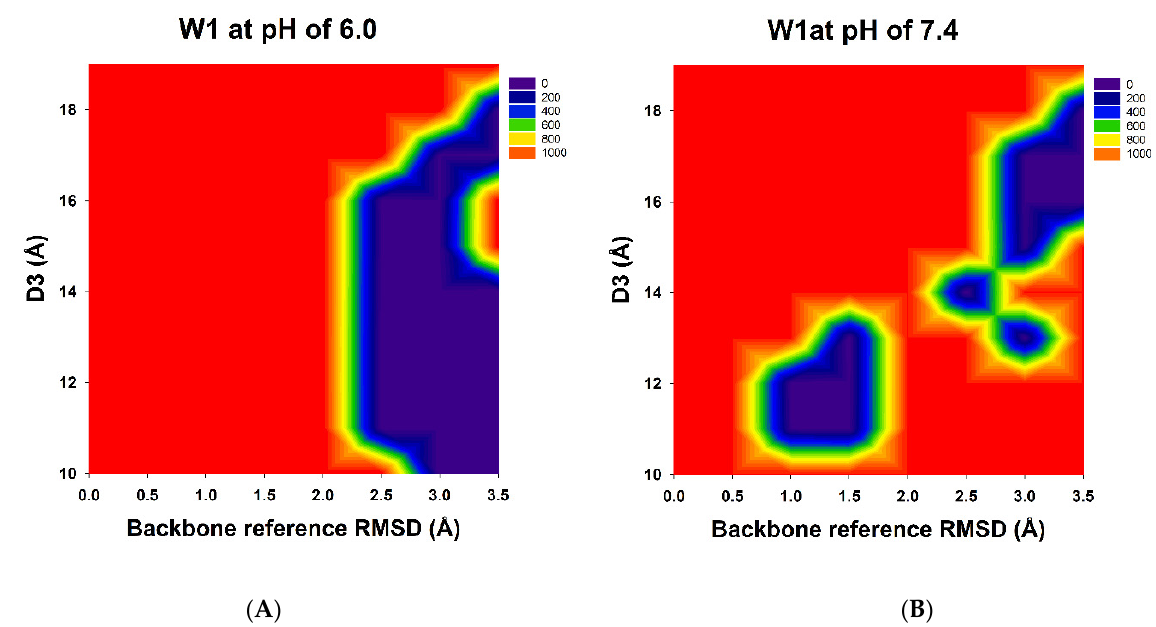
Figure 3. The 2D PMF profiles of the backbone reference root-mean-square deviations (BRRMSD) of the CDRs (HCDR2-3 and LCDR1–3) and the distances (D3) between the centers of the HCDR3 and LCDR3 were used as reaction coordinates: ( A ) W1-Humira at pH 6.0 and ( B ) W1-Humira at pH 7.4. Table 1. Possible antibody conformation states based on Gaussian accelerated molecular dynamics/constant pH molecu-